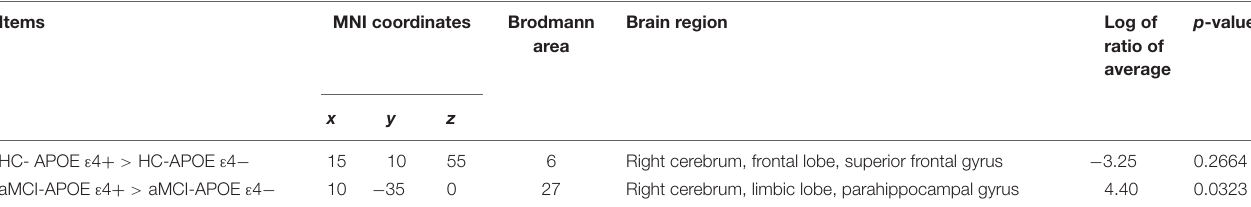
FIGURE 3 | Scatterplots illustrating the correlation between P300 amplitude and Z scores of information processing speed in 0-back task (A) , Z scores of information processing speed in 1-back task (B) , and Z scores of executive function in 1-back task (C) in healthy controls and aMCI patients partialing out the effect of age, gender, years of education, and APOE ε 4 status. Red circles represents HC. Blue circles represents aMCI patients. Abbreviations: aMCI, amnestic mild cognitive impairment; APOE, apolipoprotein E; HC, healthy controls. TABLE 4 | Comparison of participants with different APOE ε 4 status in sLORETA in HC and aMCI patients, respectively (voxels showing maximal